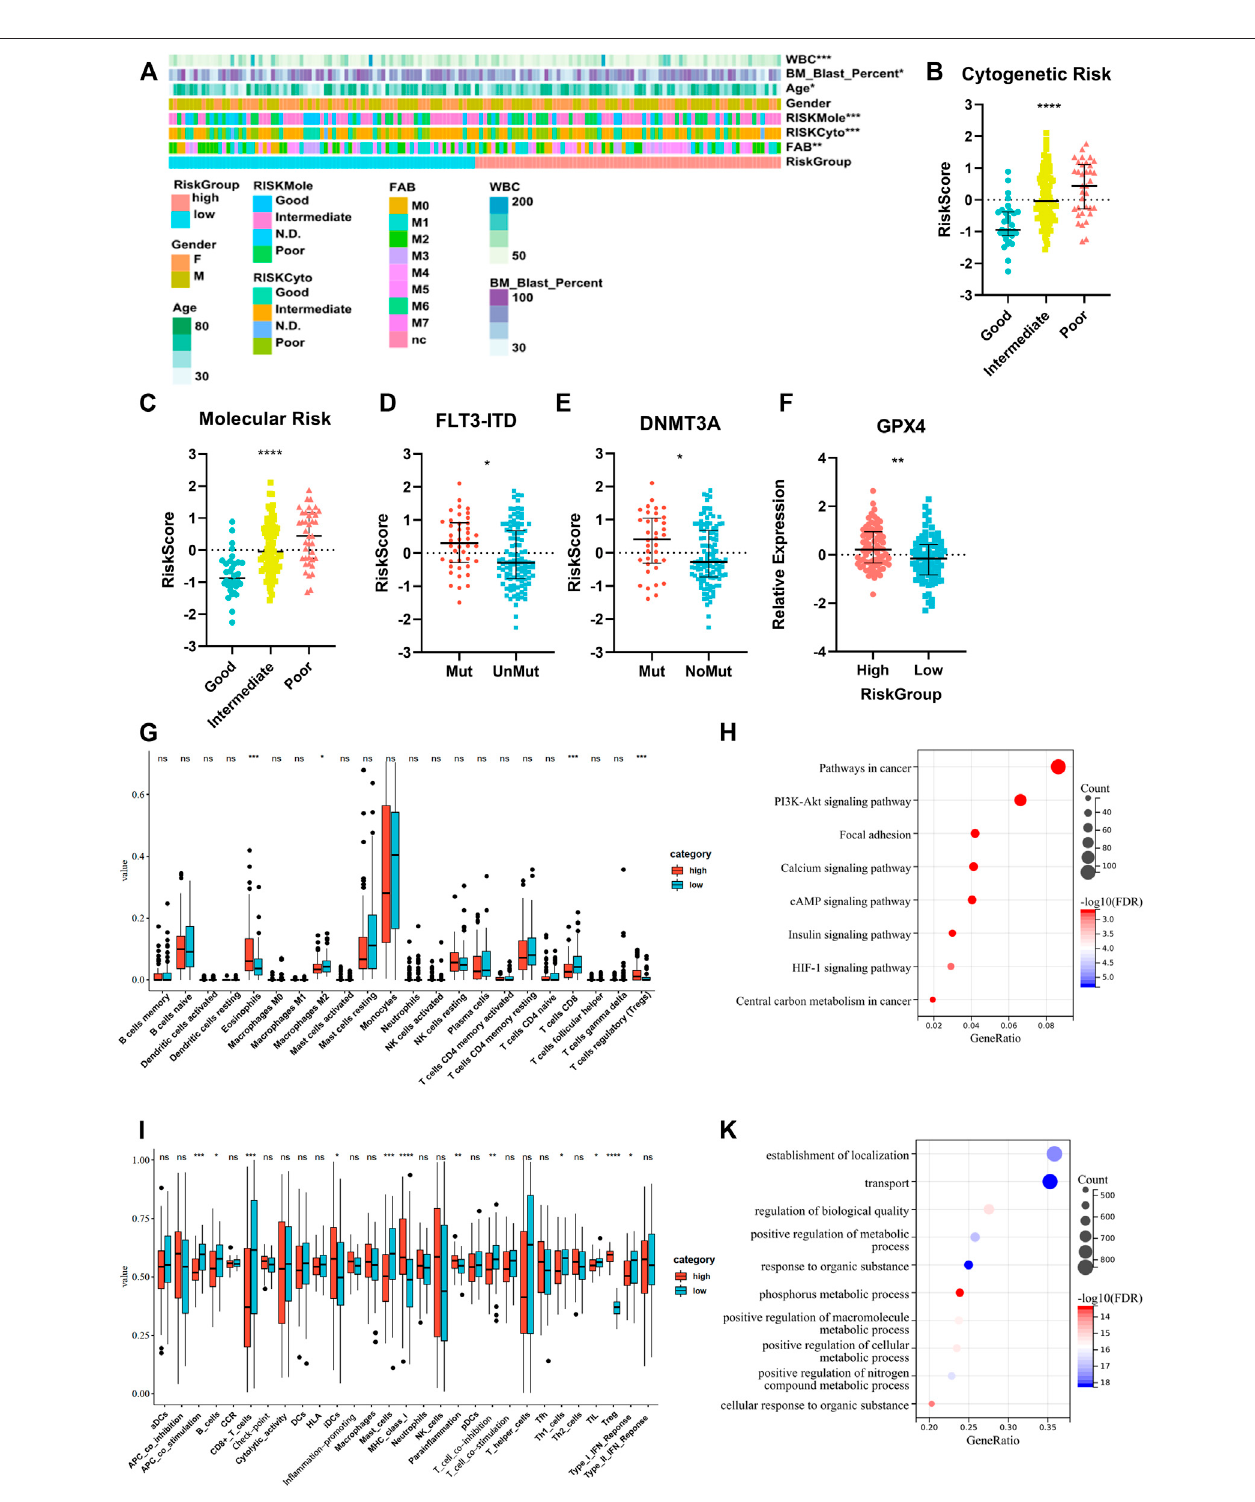
FIGURE 7 | Analysis of differences in clinical characteristics, immune cell proportion, and functional enrichment of patients in different risk groups. (A) Clinicopathological features were compared between low-risk and high-risk groups (Categorical variables, Chi-square tests; continuous variable, Wilcoxon tests * p < 0.05;** p < 0.01;*** p < 0.001). (B , C) Comparisonoftheriskscoresofpatientswithdifferentcytogeneticandmolecularrisktypes(Kruskal – Wallistest). (D , E) Comparison of the risk scores between patients with or without FLT3-ITD and DNMT3A mutations (Wilcoxon test). (F) Comparison of GPX4 expression between patients in high-andlow-riskgroups(Student ’ st-test). (G , I) Differentimmunecellfractionandimmuneresponsebetweenthetwosubtypes,withCibersortXandssGSEAalgorithm (Wilcoxon test). (H , K) GO and KEGG pathway analysis for differentially expression genes between the two risk groups (Fisher ’ s exact-test).